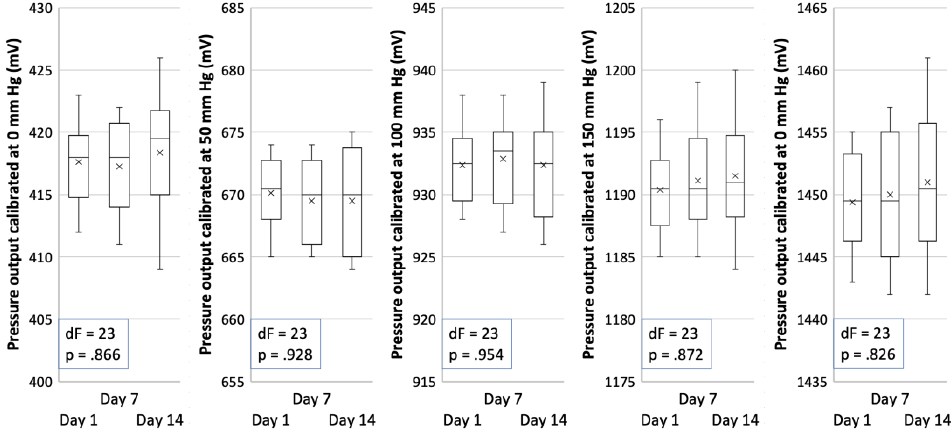
Figure 7. Device calibration data showing blood pressure output in mV on different experimental days. dF and p values of ANOVA are presented in the chart.